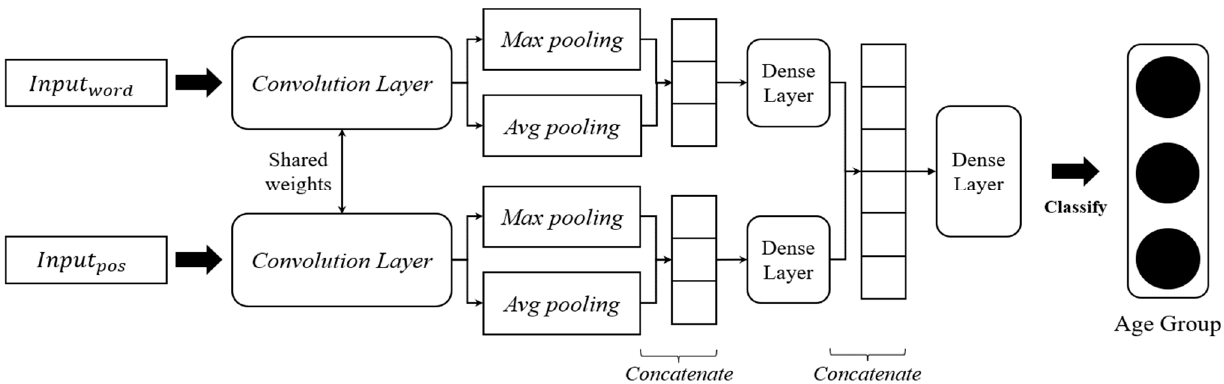
Figure 1. Architecture of language development screening model.